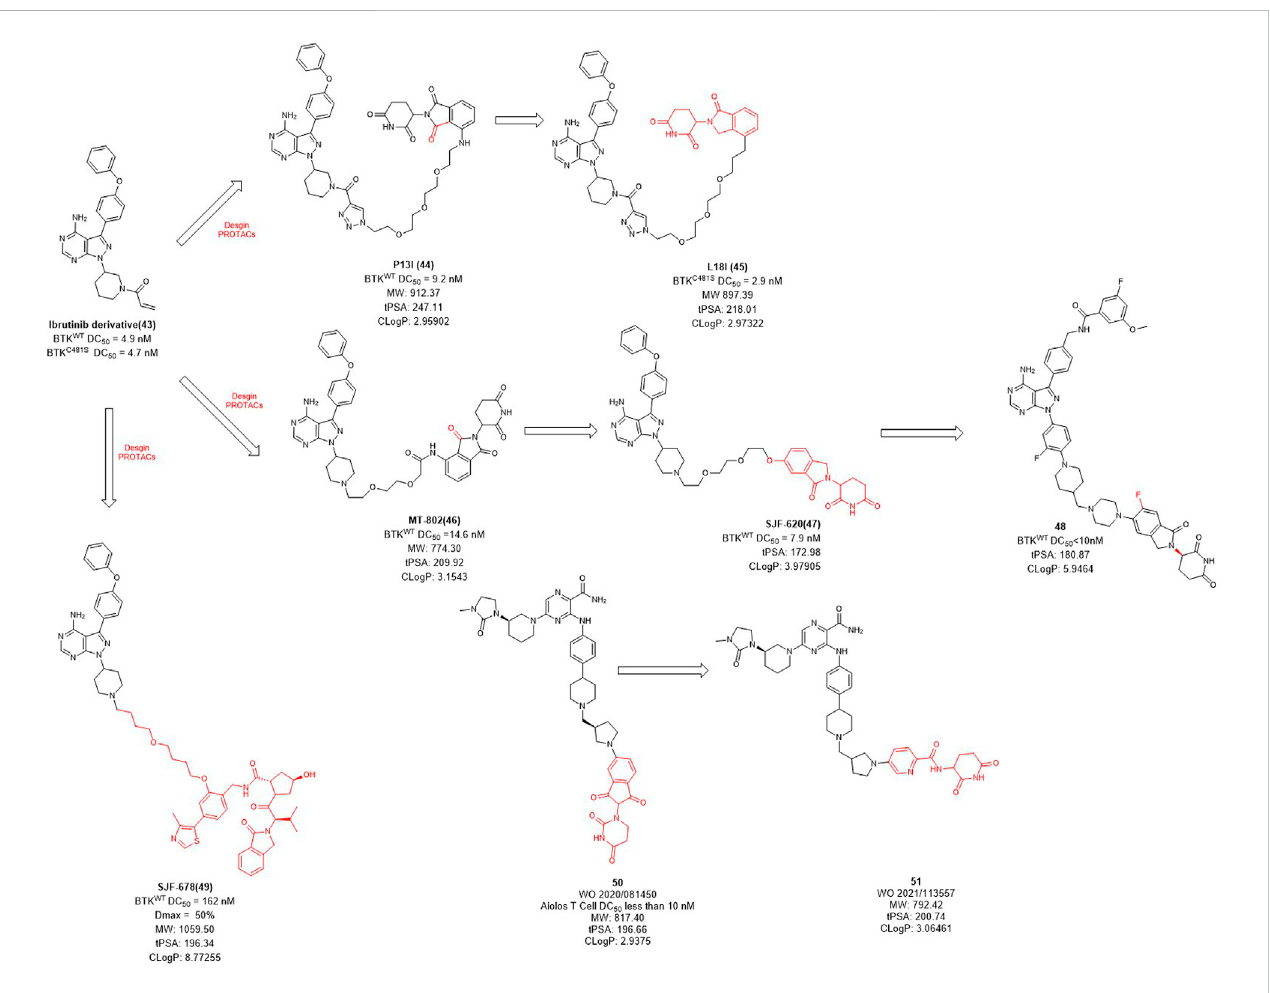
FIGURE 4 Design and optimization of BTK